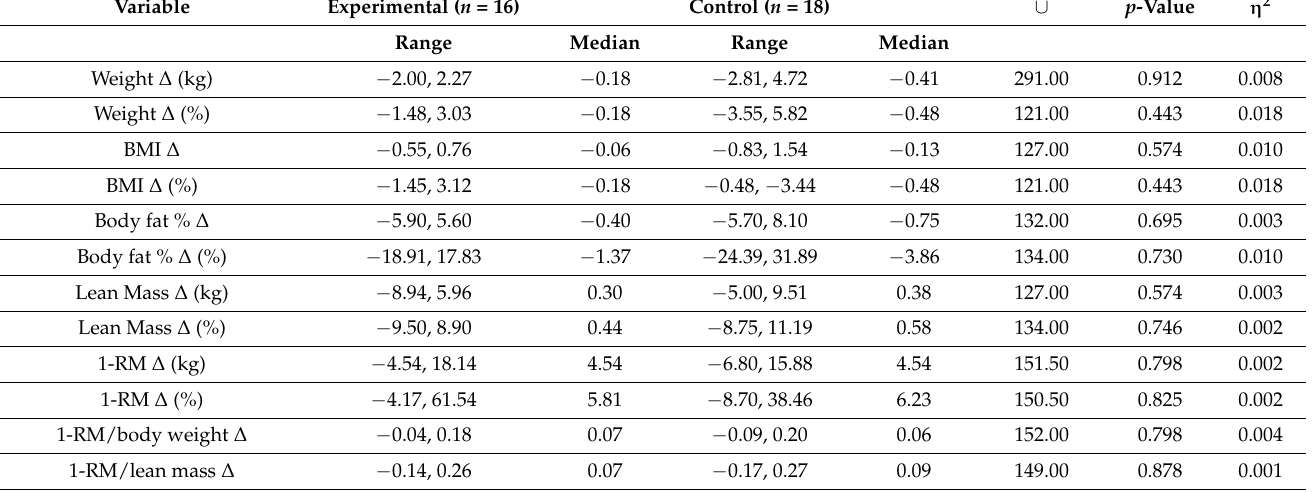
Table 2. Pre–post differences (range,